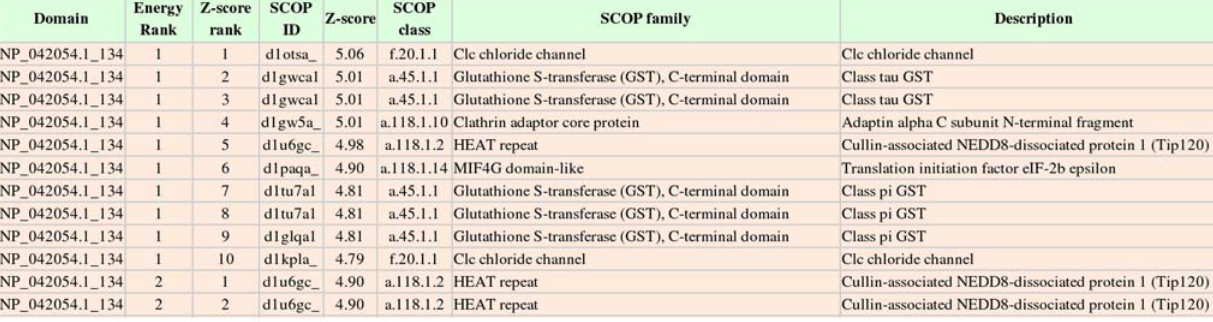
Figure 4. Screenshot of the pipeline-rendered SCOP annotations derived from the abinitio results in HTML format for variola protein NP_042054.1. The full output (not shown) includes a total of 5 models (ranked by GB22 energy) and the top 10 SCOP matches for each model.